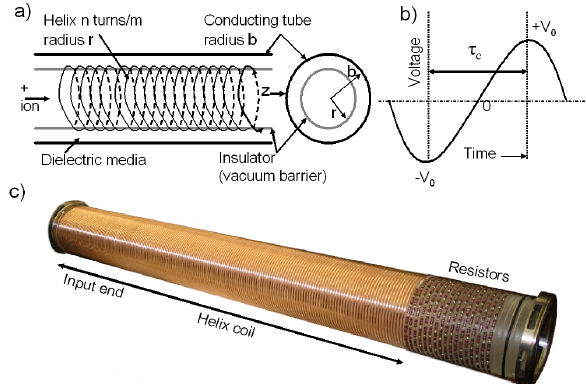
FIG. 1. (Color) (a) A schematic of the helical pulse line struc- ture. Helical pulse line of radius r is located inside of a con- ducting cylinder of radius b , and a dielectric media of permit- tivity (cid:2) is located in the region outside the helix. (b) Schematic of a drive voltage waveform applied at the helix input. (c) Mechanically constructed helix for the PLIA